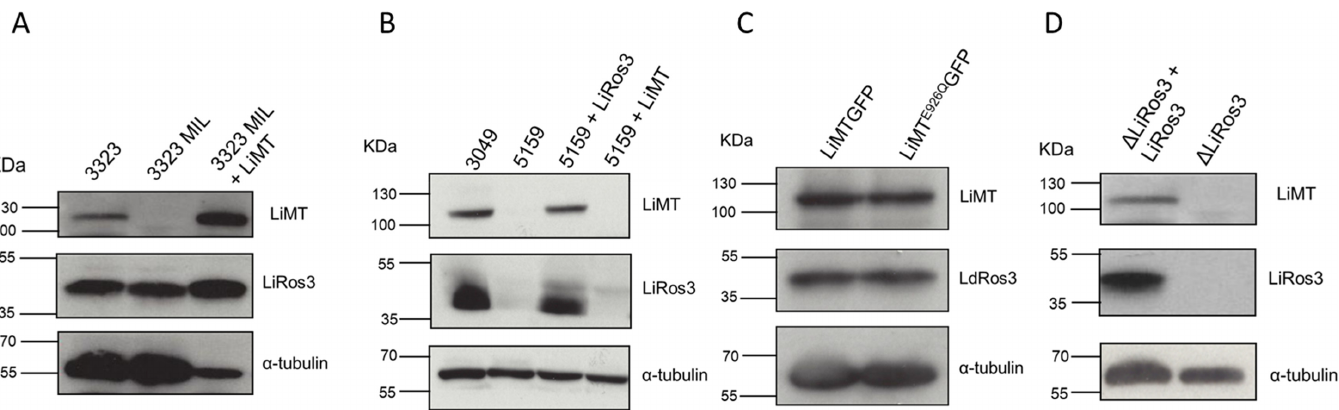
Fig 2. Analysis of the expression levels of the MIL-translocation machinery in different Leishmania strains. Extracts from (A) L . infantum LEM3323 (3323), LEM3323-MIL (3323MIL), LiMT -transfected LEM3323-MIL (LEM3323-MIL + LiMT ), (B) LEM3049, LEM5159, LiRos3 - and LiMT -transfected LEM5159 (LEM5159 + LiRos3 ; 5159 + LiMT ), (C) L . donovani Δ LdMT promastigotes transfected with LiMT GFP and with LiMT E926Q GFP and (D) Δ LiRos3 and Δ LiRos3 + LiRos3 lines were subjected to SDS/PAGE and immunoblotted with the rabbit polyclonal anti- LdM T and anti- LdRos3 antibodies. Anti- α - tubulin monoclonal antibody was used as a probe for a protein loading